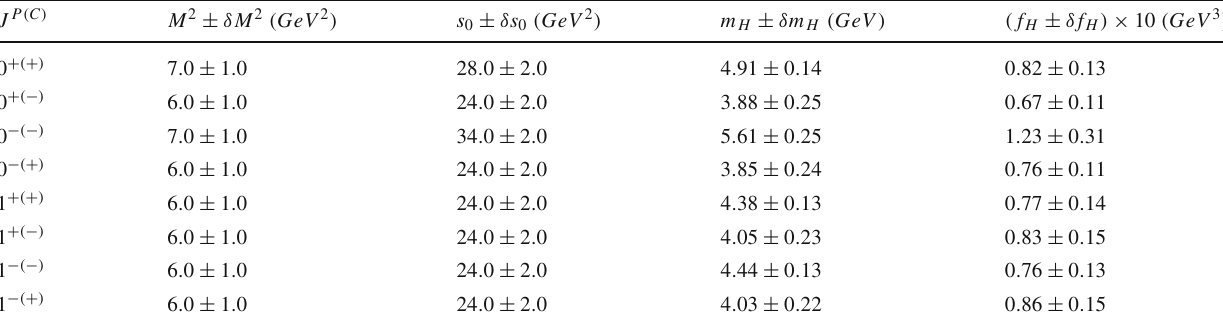
Table 6 Values of the mass and current coupling for different quantum numbers of the ground state charm-strange hybrid